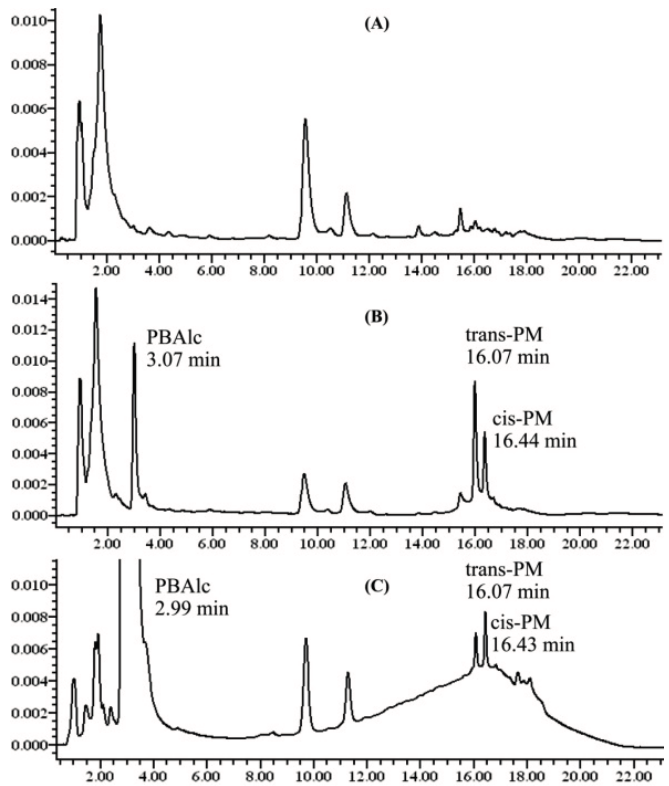
Figure 3. Representative chromatograms for the separation of PM and PBAlc in rat plasma; ( A ) blank plasma; ( B ) blank plasma spiked with standards of PM and PBAlc (3.2 µg/mL); ( C ) plasma sample at 8 h after dosing with PM (460 µg/mL, p.o.). Plasma concentration-time profiles of trans -PM and PBAlc in rats pretreated with a single and multiple oral dose(s) of MG (40 mg/kg) and AE (100 mg/kg) are presented in Figure 4. PBAlc and trans -PM concentrations were measurable in the plasma during 8–22 h post dose and gradually declined over time. After 22 h, the levels of trans -PM in the plasma of rats given a single dose and multiple dose pretreatment of MG were below the